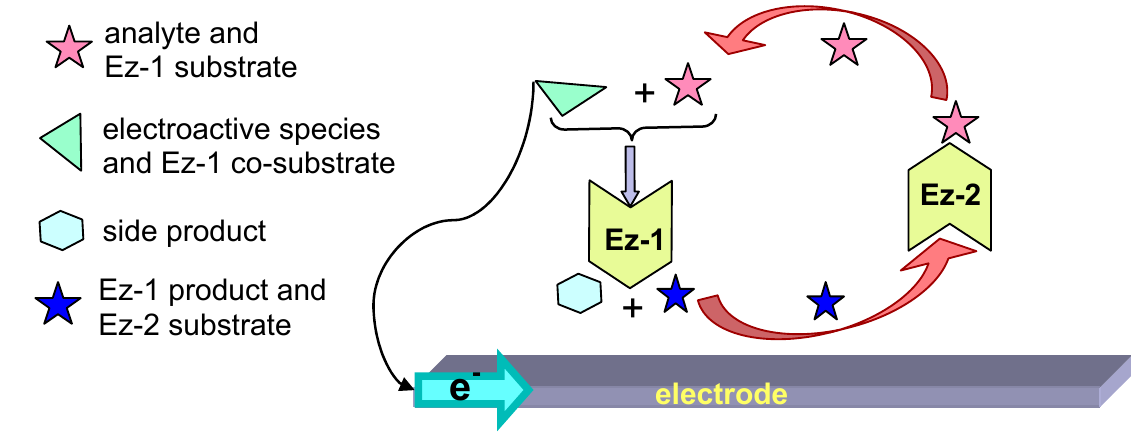
Figure 8 . Schematic representation of a bi-enzymatic amperometric biosensor. The analyte, ( ) is recycled as long the electroactive species ( ) is